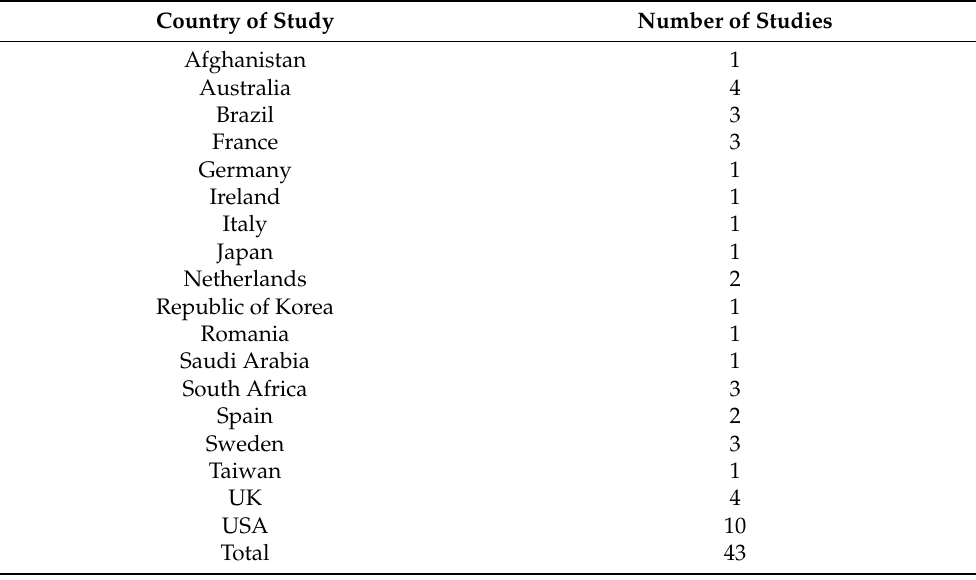
Table 2. Country where evaluation took